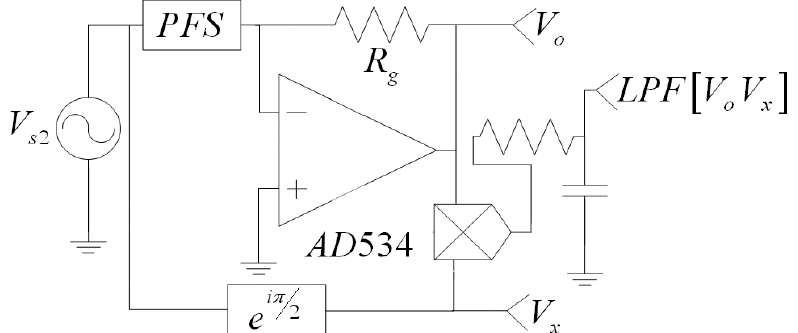
by means of removing the conductance term s V ] o x